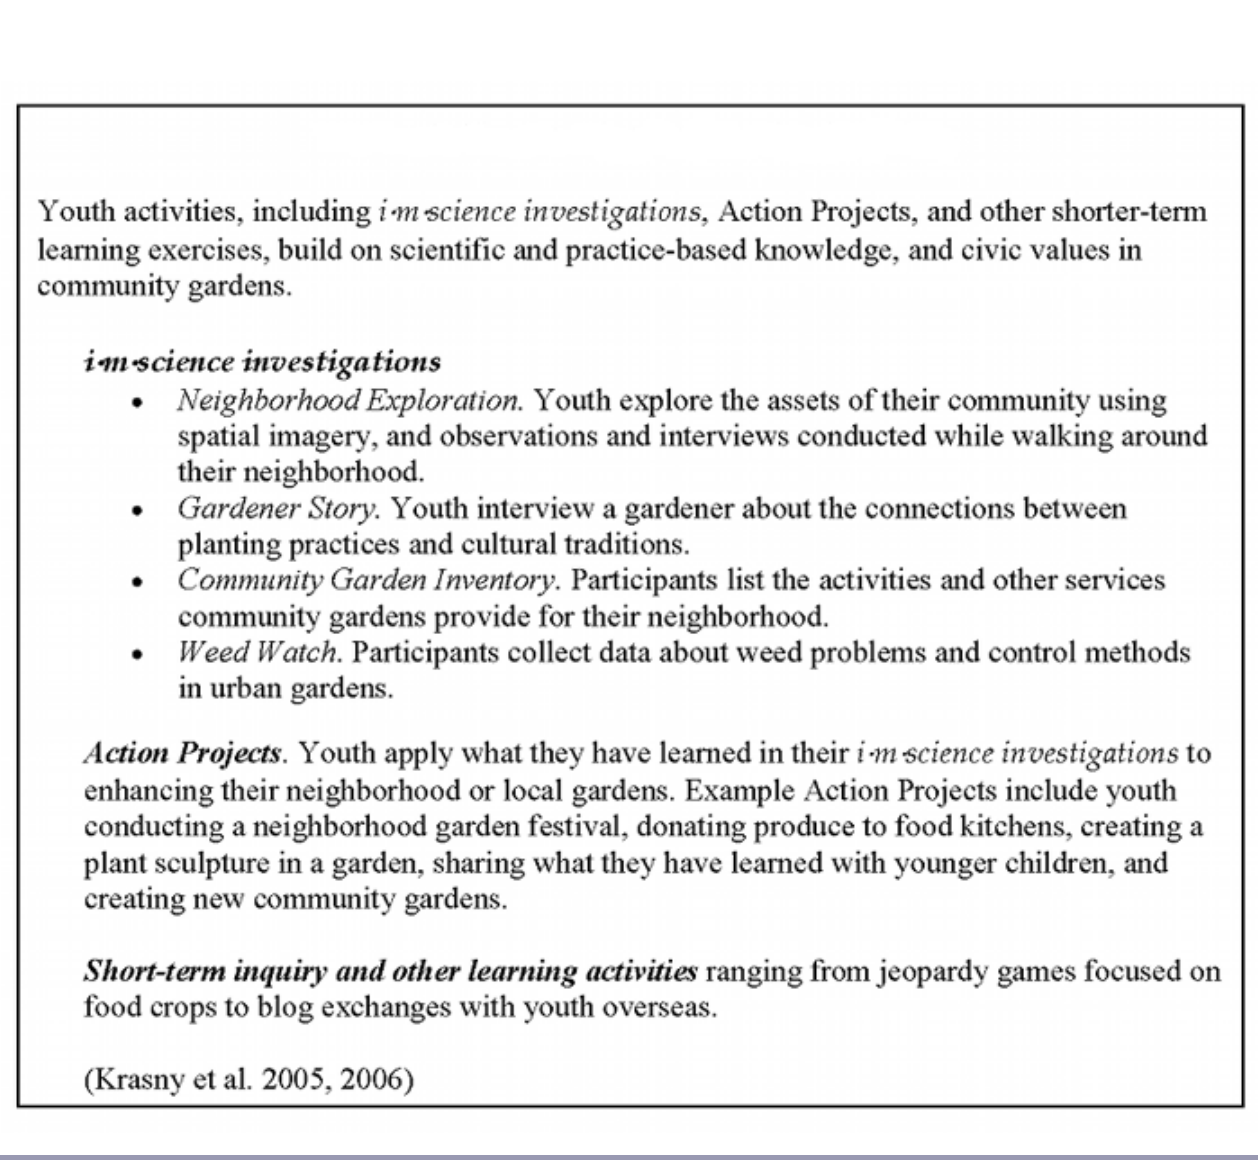
Fig. 1. Garden Mosaics learning